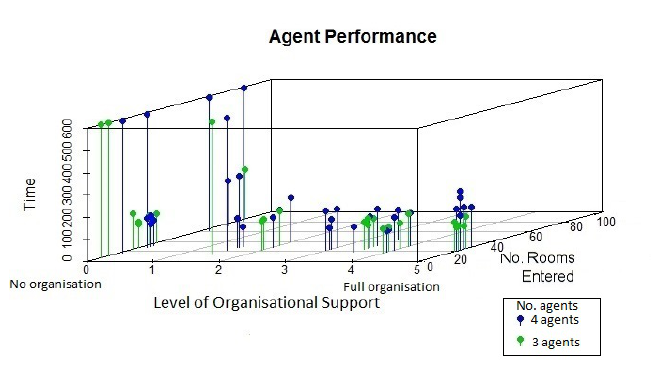
Figure 6. Agent performance in 4-room search and